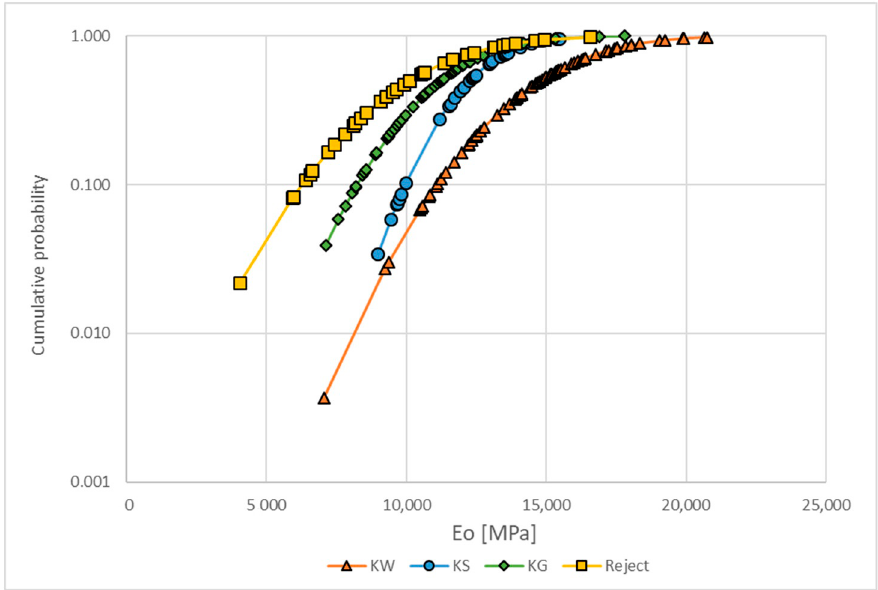
Figure 6. Distribution of modulus of elasticity parallel to the grain for different strength grades of Scots pine timber in a logarithmic scale.